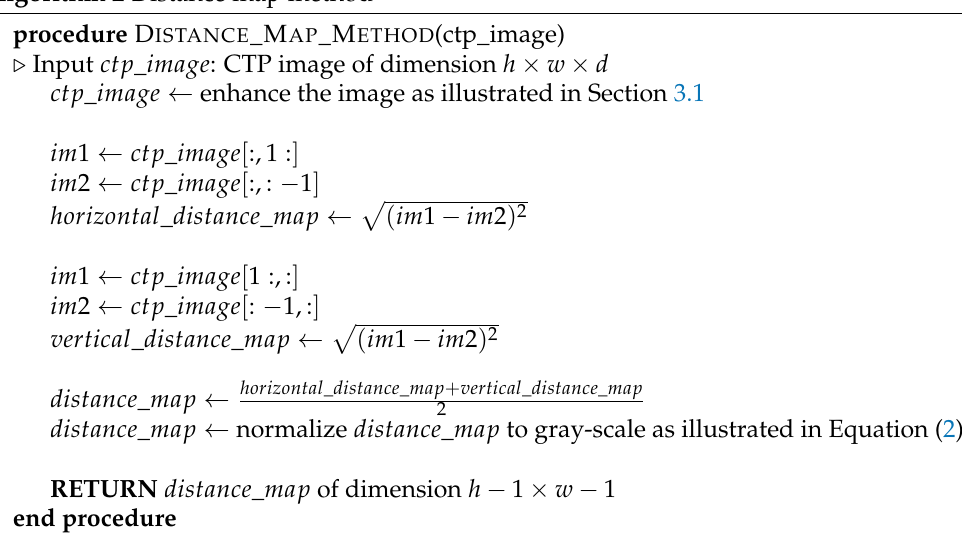
Algorithm 2 Distance map